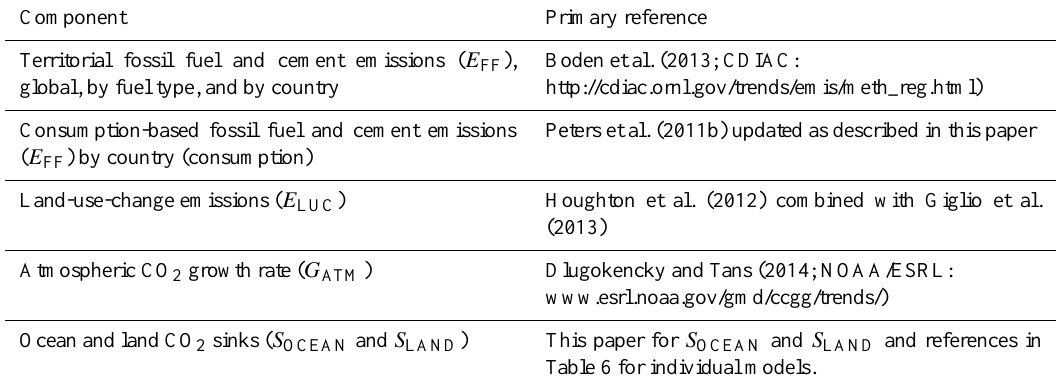
Table 2. How to cite the individual components of the global carbon budget presented